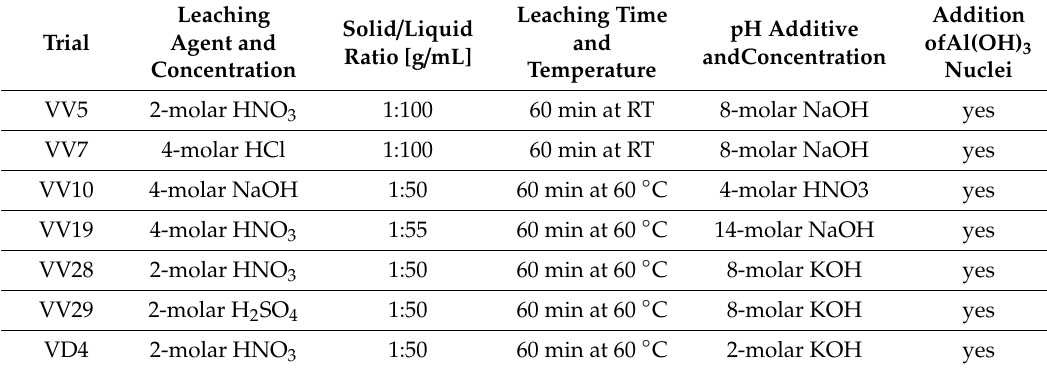
Table 7. Summary of parameter combinations with the highest lithium yields of each leaching agent. Since the yields of pre-trials VV5, VV19, and VV28 show similar lithium yields, all three are highlighted. Every parameter combination is represented once. Leaching Trial Agent and Ratio [g / mL]